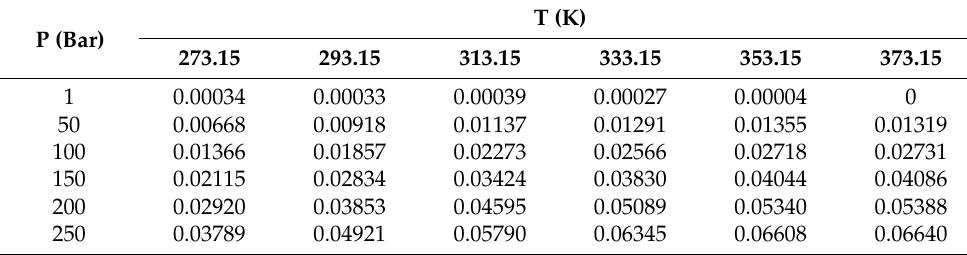
Table 7. Calculated H 2 solubility (mol/kg) in a 5 mol/kg NaCl